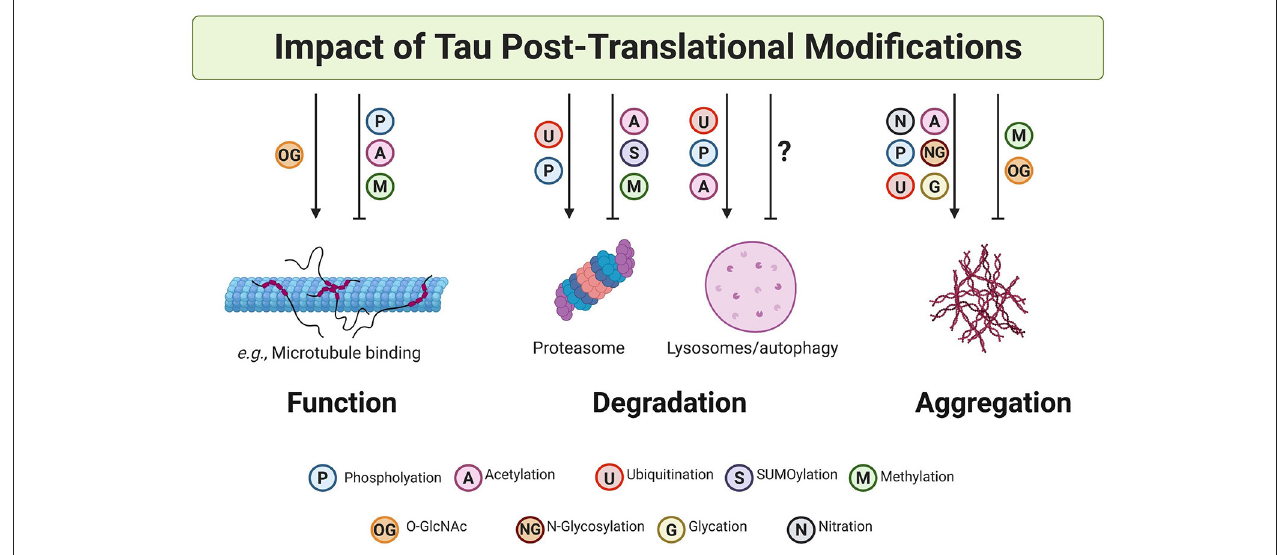
FIGURE 4 | Post-translational modifications on tau impact tau function, degradation, and aggregation. PTMs can both promote and inhibit tau function, clearance, and aggregation. A non-exhaustive list of examples are illustrated here. In many cases, it is likely that cross-talk and competition between PTMs results in the specific and dynamic regulation of